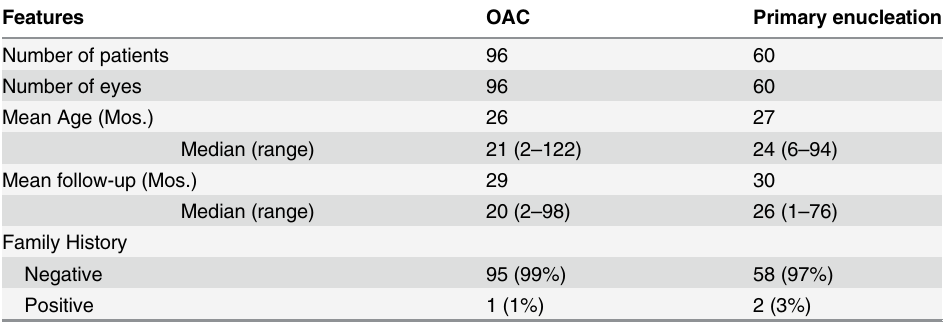
Table 1. Clinical Characteristics of Eyes with Advanced Stage Unilateral Retinoblastoma. Eyes are either treated with OAC or primary enucleation.